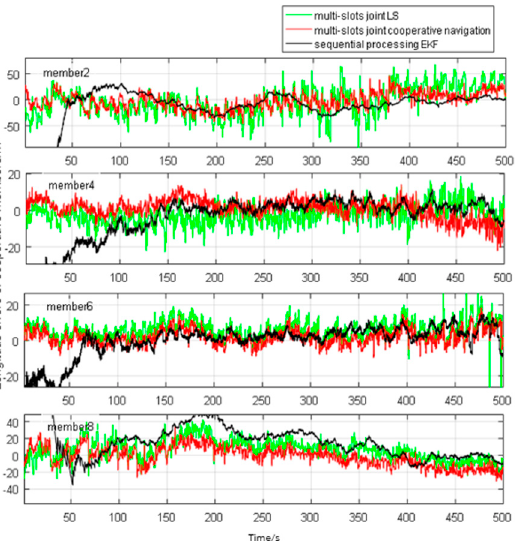
Figure 11. RMS altitude error comparison between TDMA datalink cooperative navigation, se- quentially processing EKF, and TDMA datalink WLS.